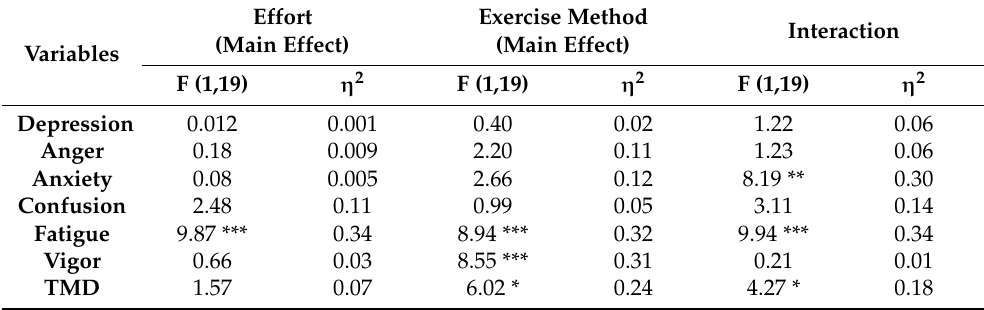
Table 2. Analysis of Variance results with 2 × 2 repeated measures (exercise method: circuit with verbal encouragement and circuit without verbal encouragement) × effort: pre- and post-exercise).